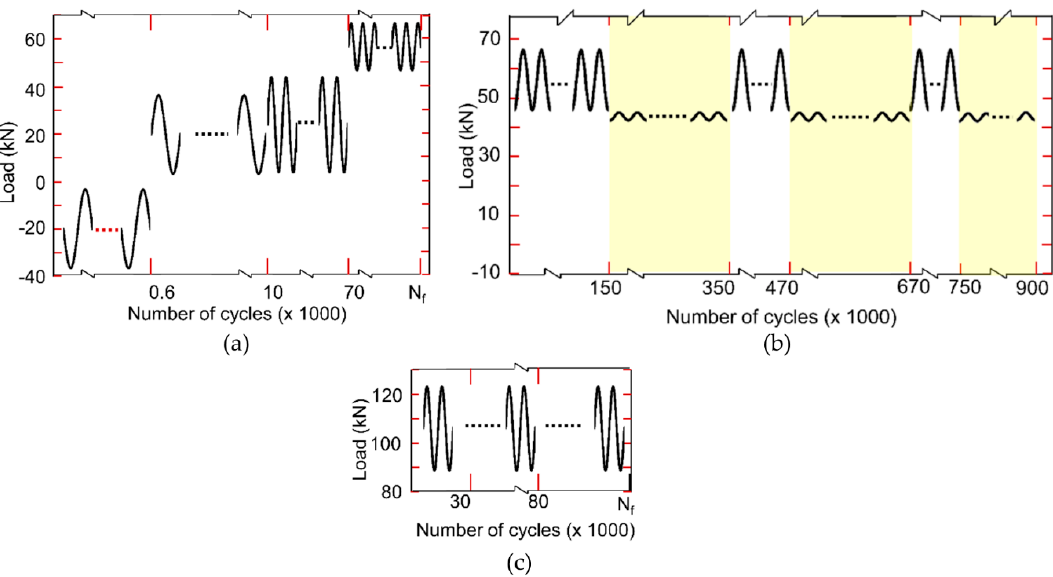
Figure 5. Loading protocols to evaluate the response of the proposed sensor during ( a ) continuous crack propagation monitoring test, ( b ) potential false positive evaluation test, and ( c ) crack re-initiation detection test, specimen with a crack-stop